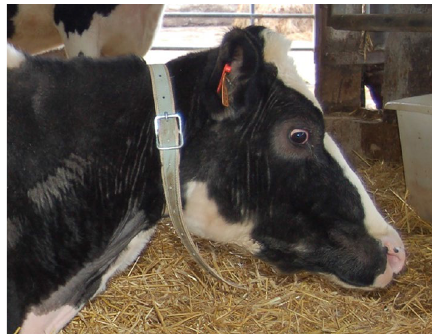
Figure 4. Cow displayed a wide-open position of the eyelids.